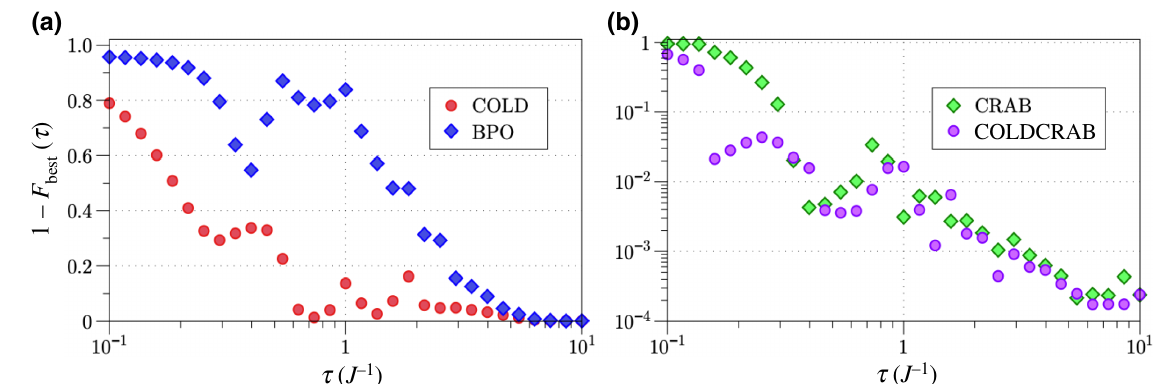
FIG. 5. Optimization of the constrained annealing protocol for the Ising model for N = 5 spins with a maximum amplitude limit on each term in the Hamiltonian of Eq. (23) of 10 J . (a) A comparison between BPO (blue diamonds) and COLD (red circles) that both give much lower fidelities (plots show 1 − F ) than in the unconstrained case in Fig. 2, although COLD persists in giving better results. In (b) the comparison is between CRAB (green diamonds) and COLDCRAB (purple circles) that show orders of magnitude better fidelities than those in (a), with COLDCRAB eking out higher fidelities at short driving times. The plotted best results are obtained from 200 optimizations for each